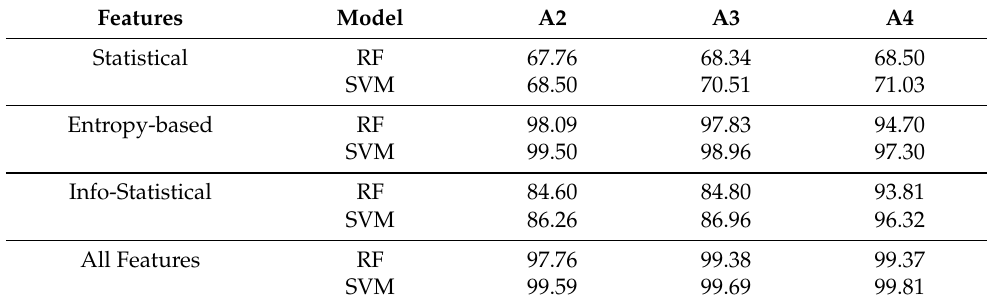
Table 3. Percentages of accuracy for fault classification using the vibration signals of the CP dataset.